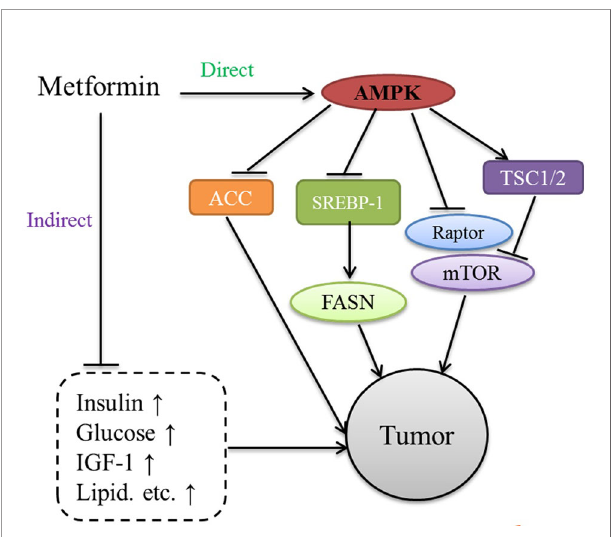
FIGURE 2 | Processes of T-cell exhaustion and metabolic